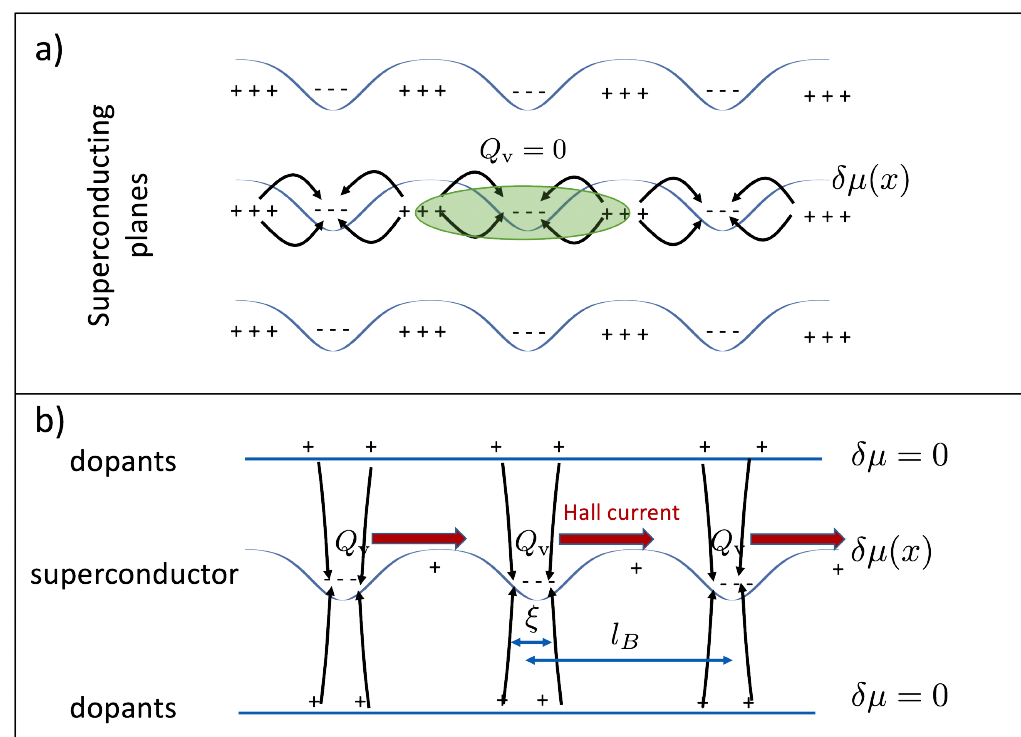
Figure 5: Three dimensional screening of vortex charge density. (a) Stacked super- conducting planes with in-plane screening. (b) Staggered dopant layers and super- conducting planes where an unscreened Hall current flows in the superconducting